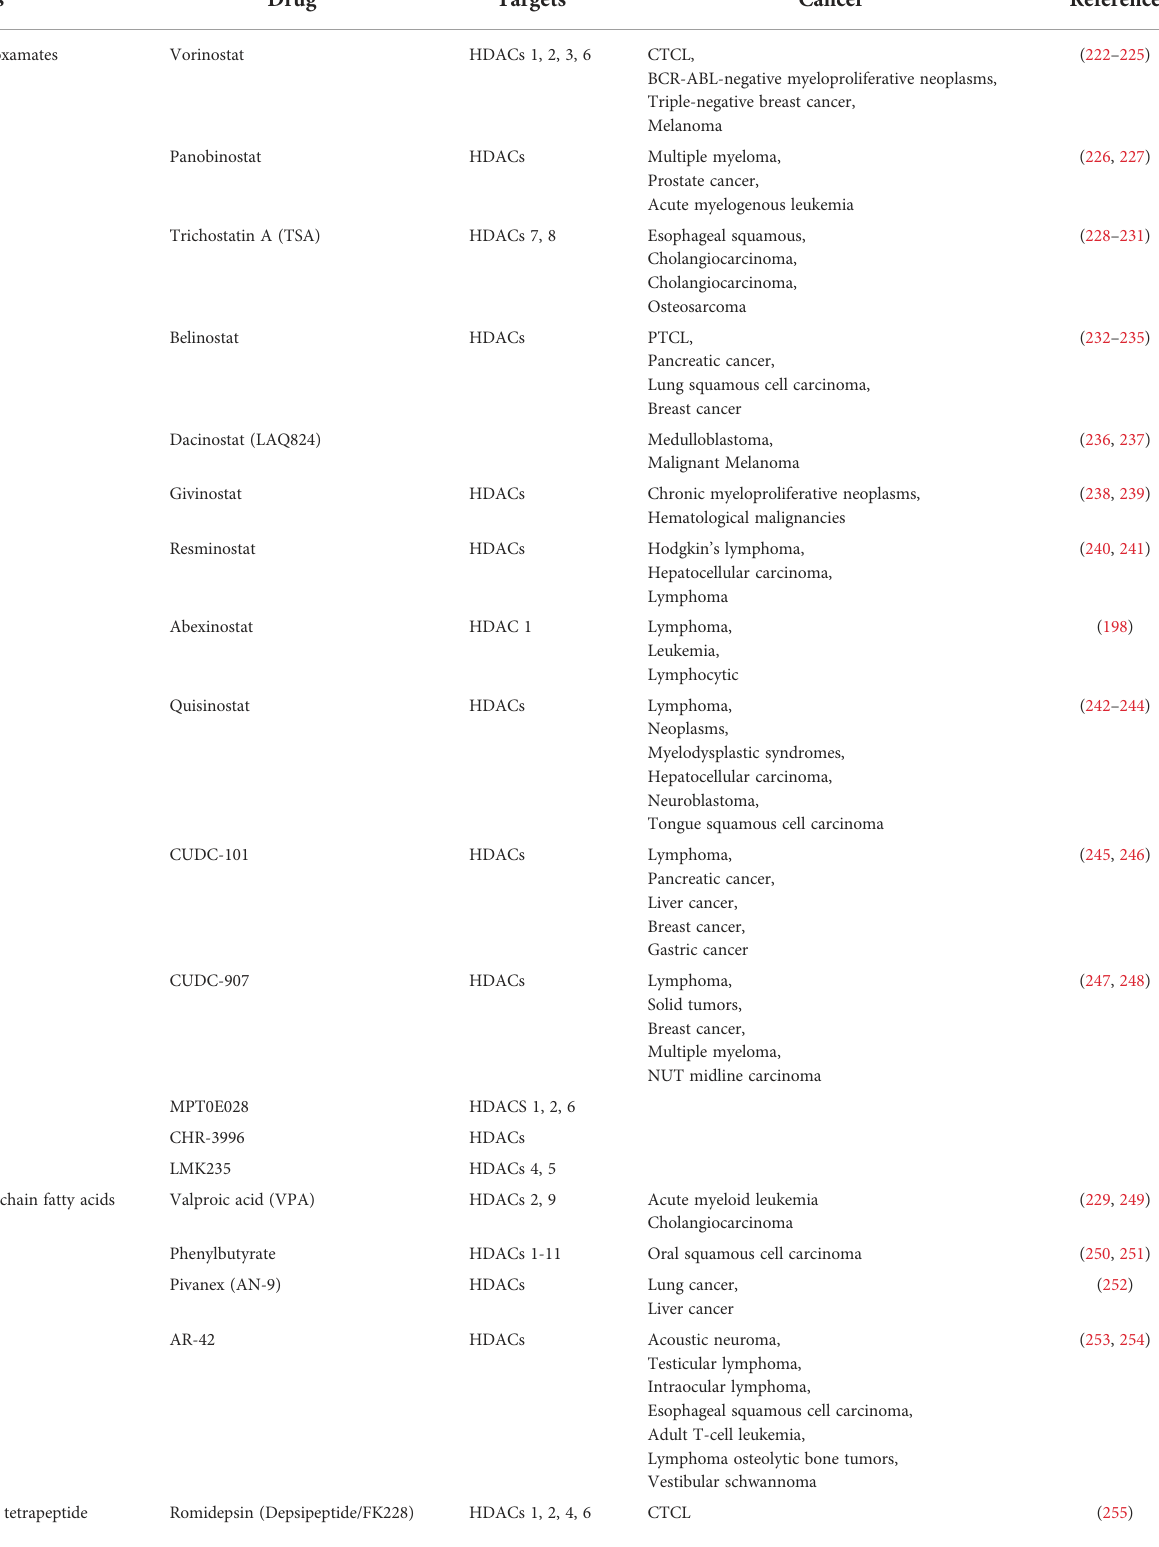
TABLE 5 Classi fi cation and targets of sirtuins in